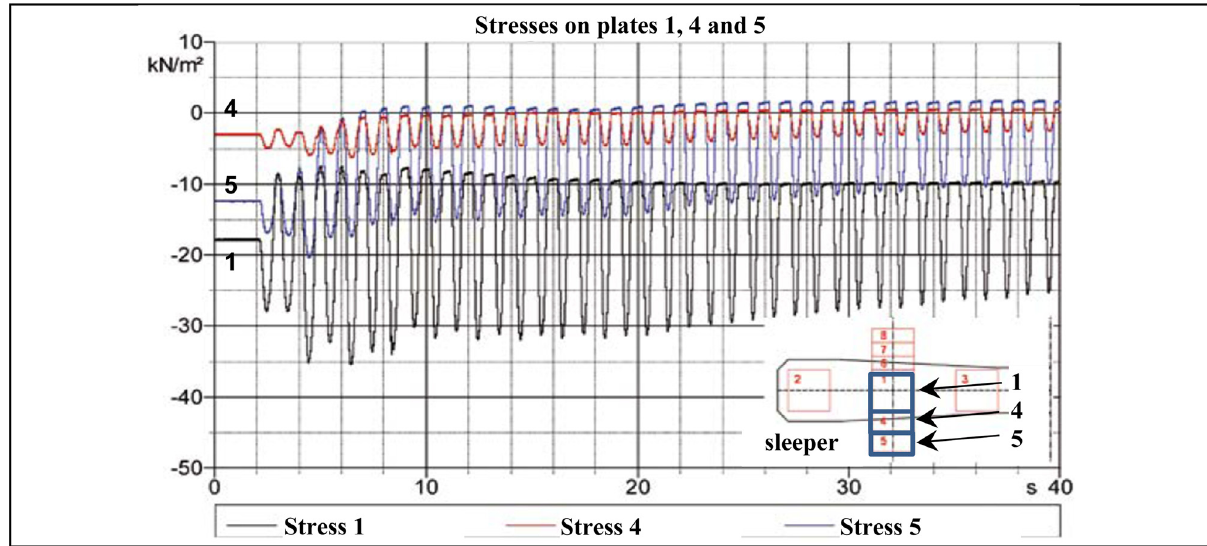
Figure 10: Distribution of the vertical ( normal ) stresses underneath the ballast layer [ 39 ] .